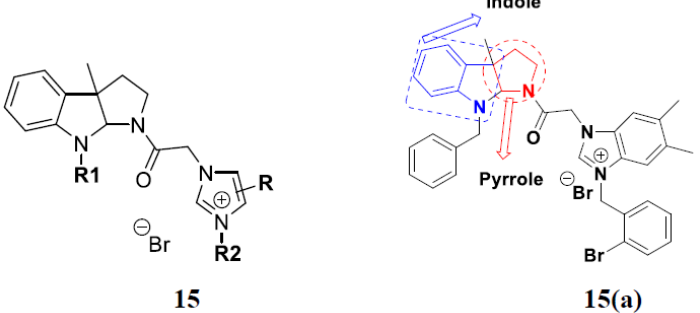
Figure 17. Structure of indole-pyrole based hybrids and the most promising compound 15a . Table 15. In vitro cytotoxic activities of indole-pyrole based hybrid compounds 15 ( b – e ).